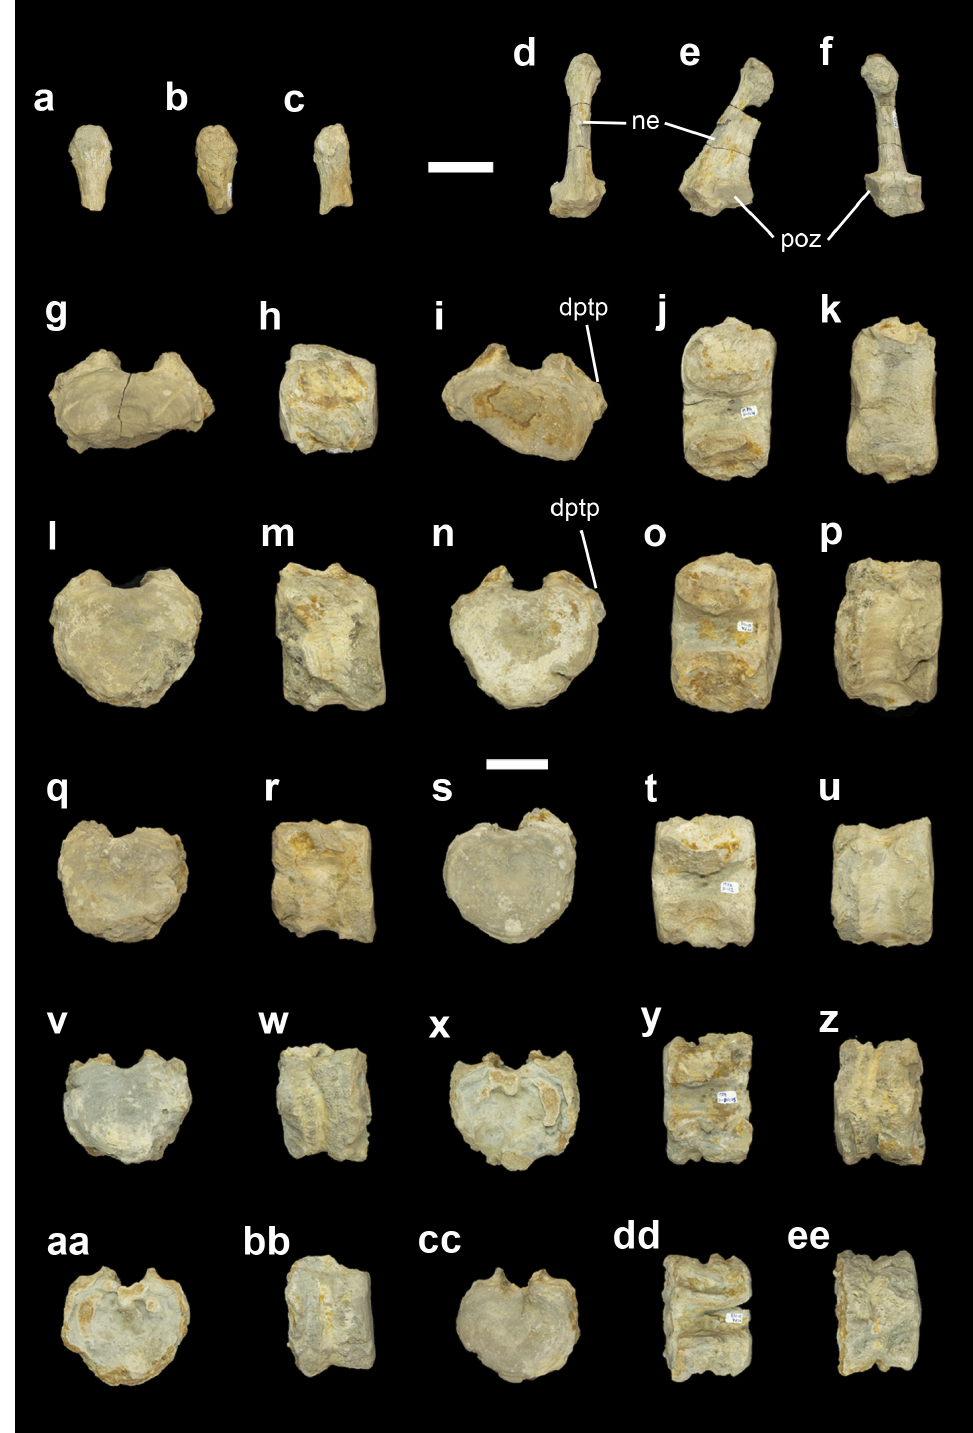
Figure 4. Fossils from Cañada París fossil site (Alpuente, Valencia, Spain). Apical fragment of a caudal neural arch (MPA D-108) ( a – c ), middle caudal neural arch (MPA D-109) ( d – f ), anterior caudal centra MPA D-114 ( g – k ) and MPA D-111 ( l – p ) and middle caudal centra MPA D-112 ( q – u ), MPA D-115 ( v – z ) and MPA D-113 ( aa – ee ) in anterior ( a , d , g , l , q , v , aa ), lateral ( b , e , h , m , r , w , bb ), posterior ( c , f , i , n , s , x , cc ), dorsal ( j , o , t , y , dd ) and ventral ( k , p , u , z , ee ) views. Abbreviations: dptp: dorsal process of the transverse process; ne: neural spine; poz: postzygapophyses. Scale bar = 5 cm.